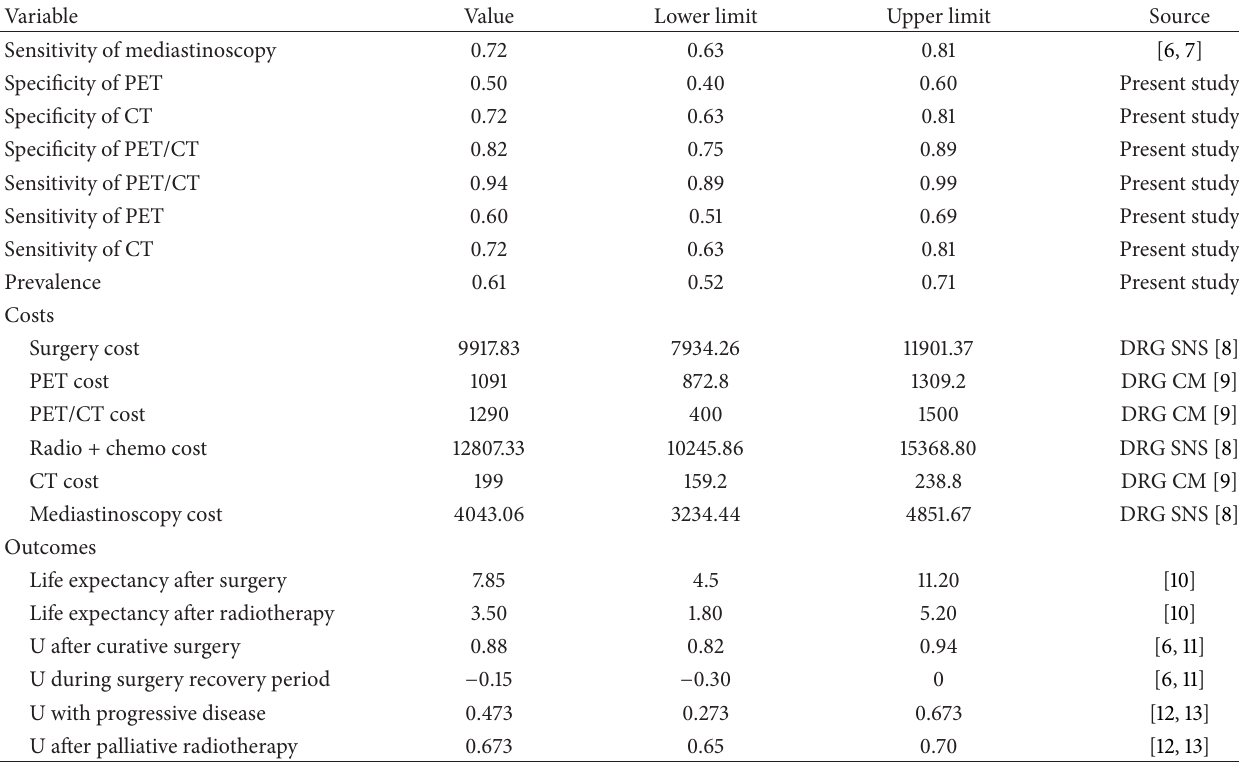
Table 1: Variables used in the cost-effectiveness analysis.